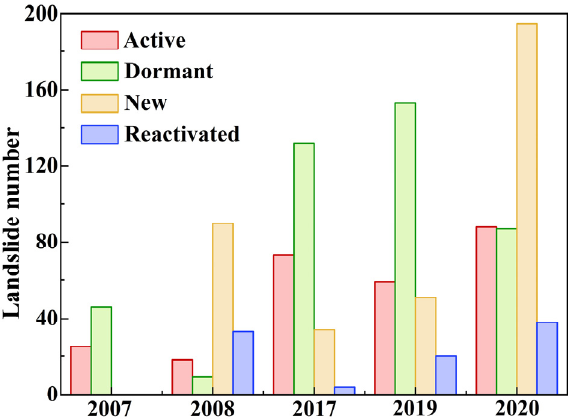
Figure 12. Distribution of landslide activity in different years.